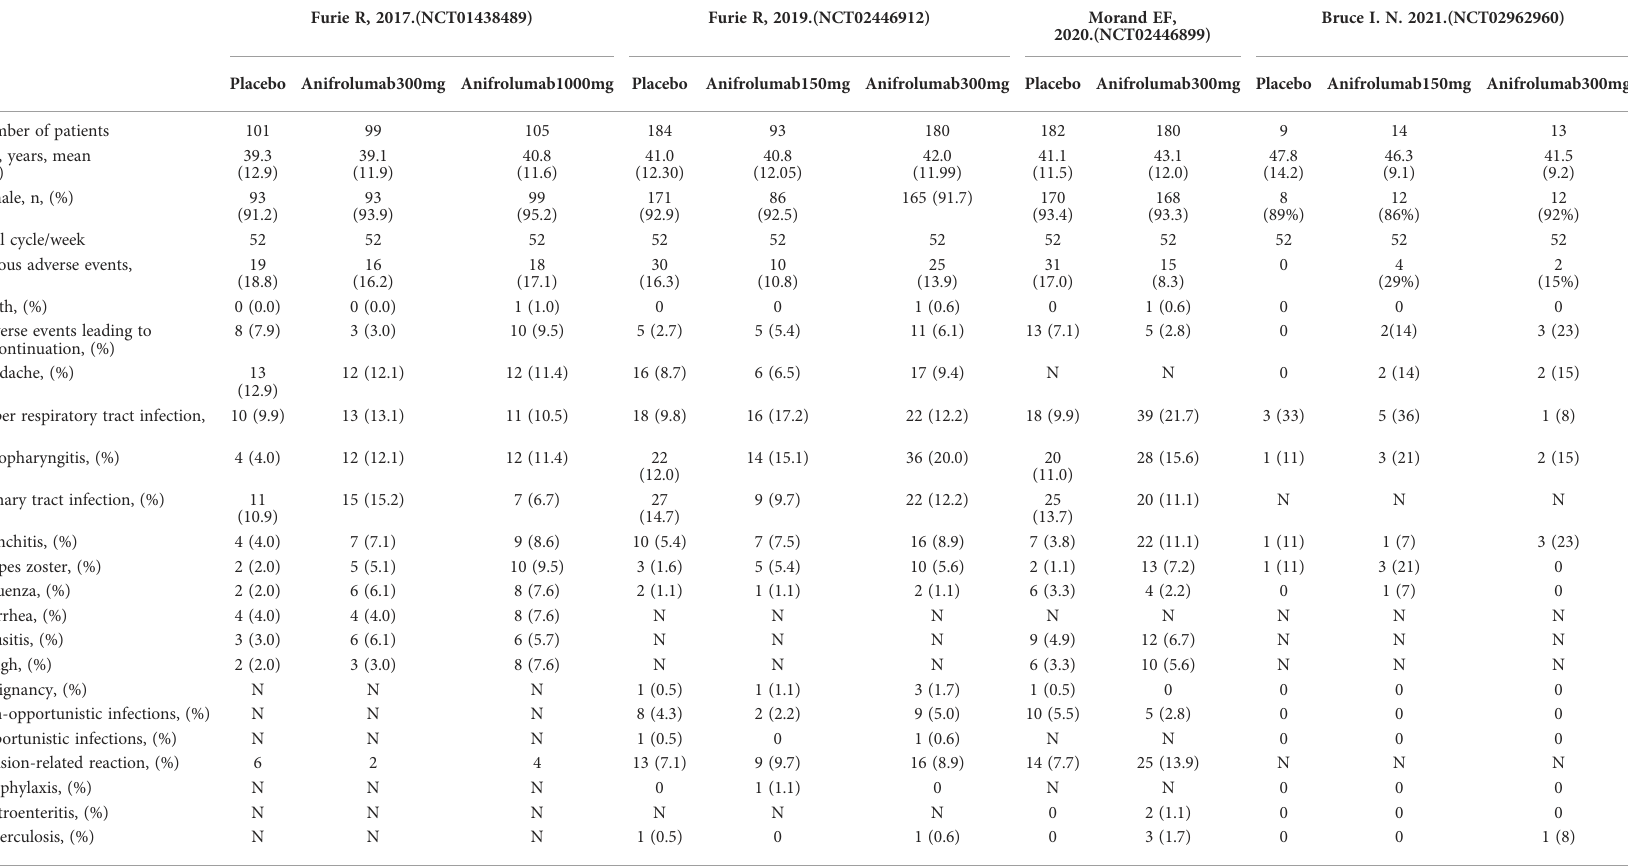
TABLE 1 Characteristics of the studies included in the